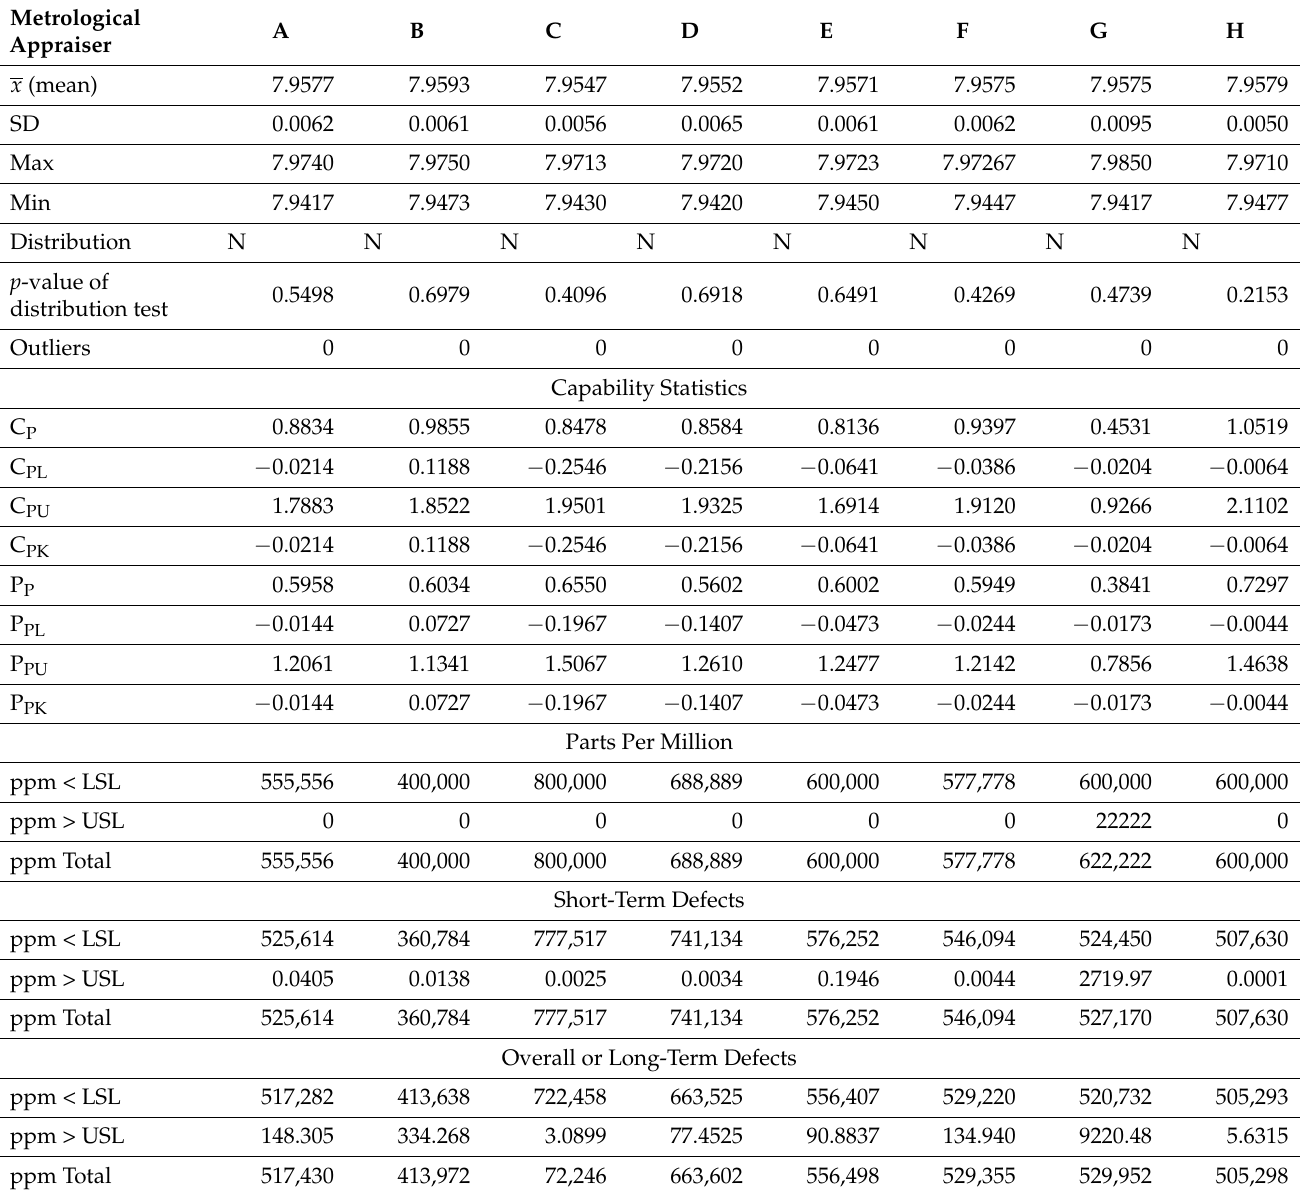
Table 1. Descriptive statistics, capability indices and numbers of noncompliant